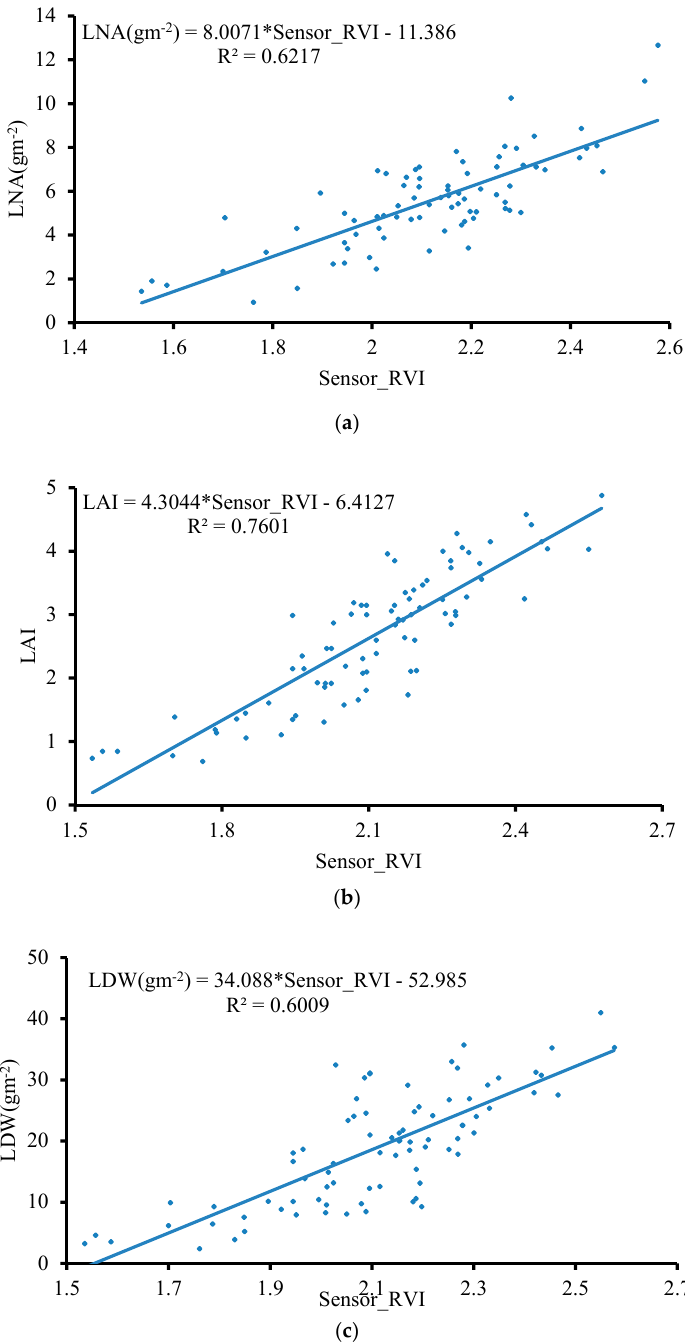
Figure 12. Spectral model for the UAV-borne crop-growth monitoring system. ( a ) LNA–RVI fitting curve; ( b ) LAI–RVI fitting curve; ( c ) LDW–RVI fitting curve.